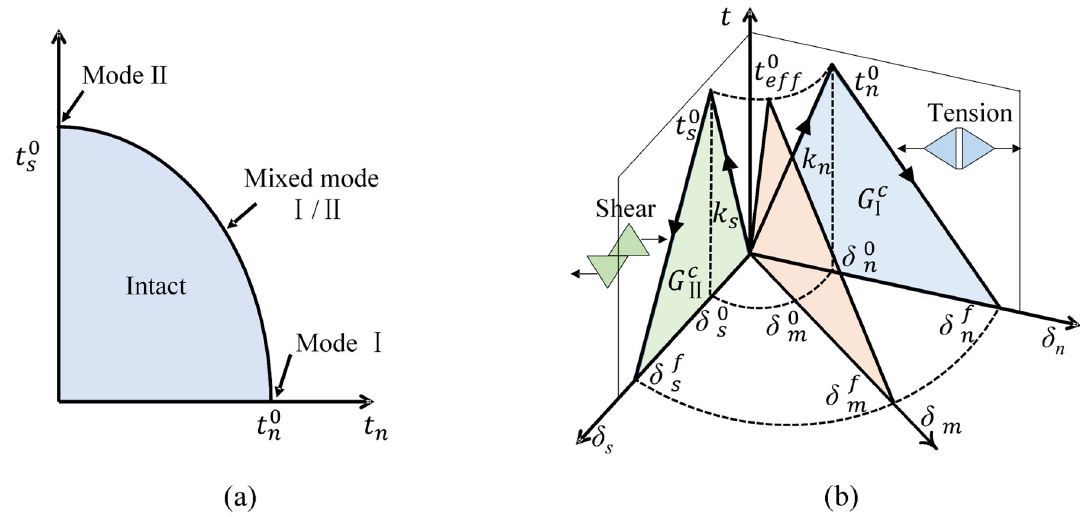
Fig 2. Constitutive model of cohesive elements. (a) mixed-mode damage initiation criterion; (b) mixed-mode linear traction- separation behavior.